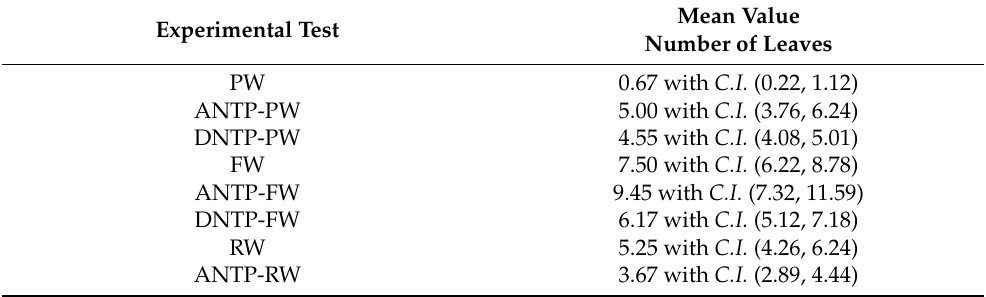
Table 5. The number of leaves in lentil plants irrigated with the hydric sources proposed in this